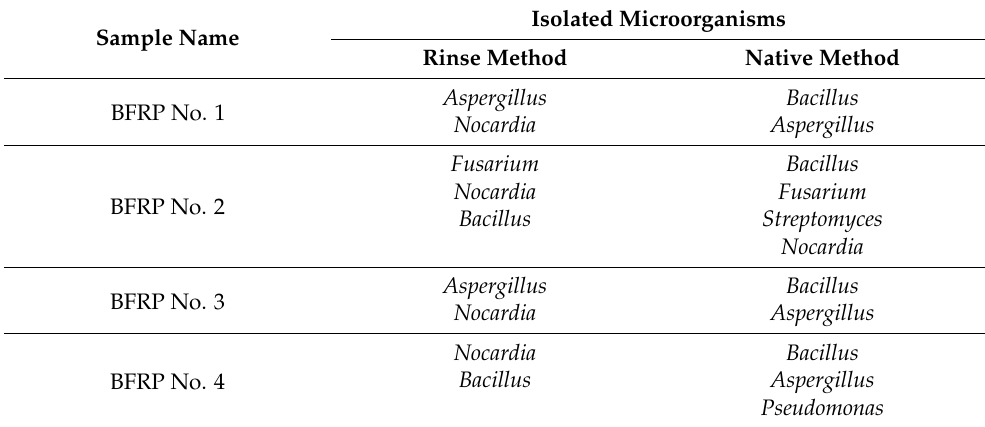
Table 3. Viable microorganisms isolated from test samples.